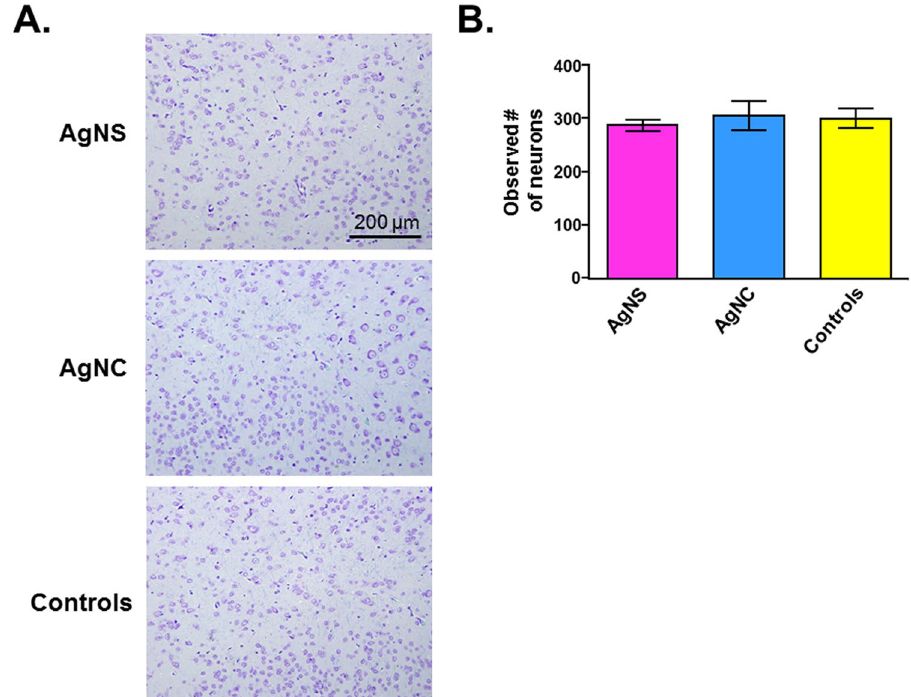
Figure 12. Comparison of neuronal density in the amygdala. ( A ) Cresyl violet-luxol fast blue staining of representative tissue sections. ( B ) Number of observed neurons per five 200x fields of view. Values are the mean ±